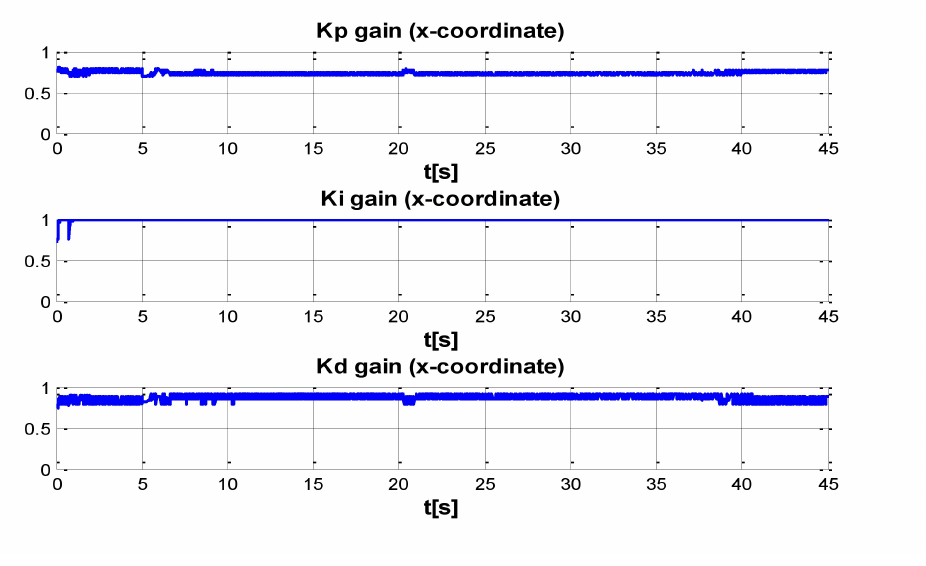
Figure 9. PID gain time behavior in